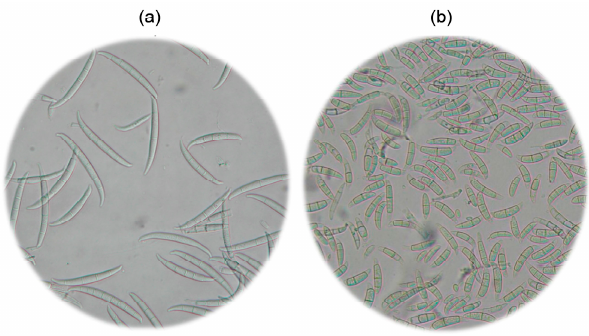
Figure 1. Microphotography of ( a ) F. graminearum and ( b ) F. culmorom macrospores (×1000).